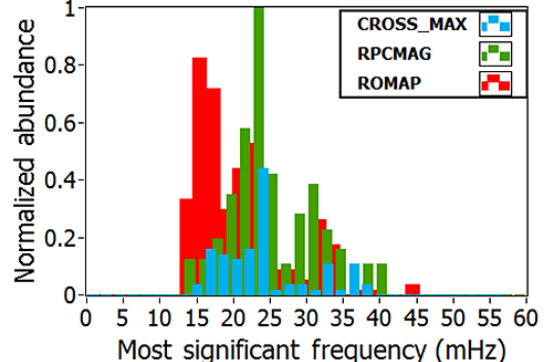
Figure 8. Profile of the most significant wave frequency (including gray error bars) versus the orbiter-lander distance. The frequency at which the cross-spectral density of RPCMAG and ROMAP mea- surements reaches its maximum value is plotted against the distance between ROSETTA and PHILAE during